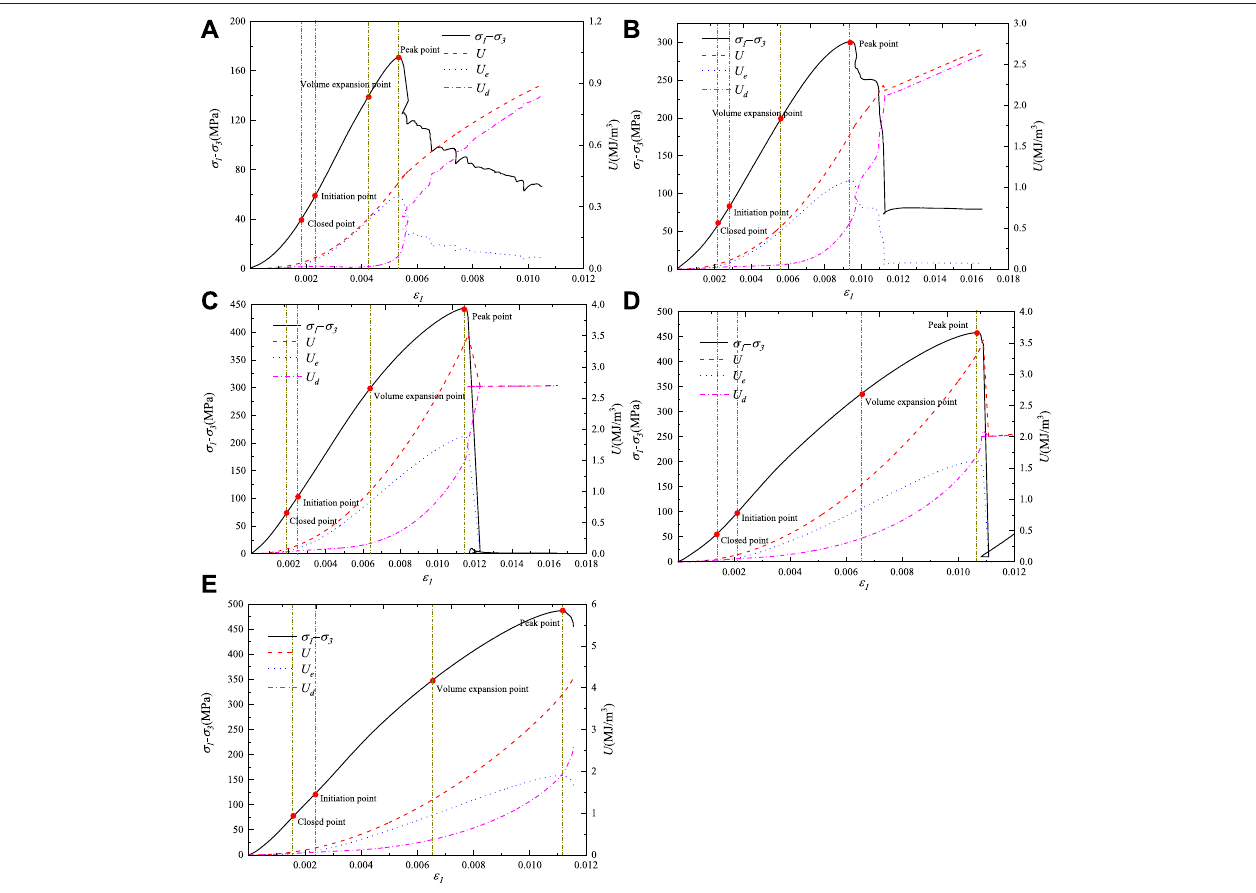
FIGURE 9 | Energy – and stress – strain curves of triaxial samples subjected to different con fi ning pressures (A) σ 3 = 0 MPa; (B) σ 3 = 10 MPa; (C) σ 3 = 30 MPa; (D) σ σ 3 = 40 MPa; (E) 3 = 50 MPa.